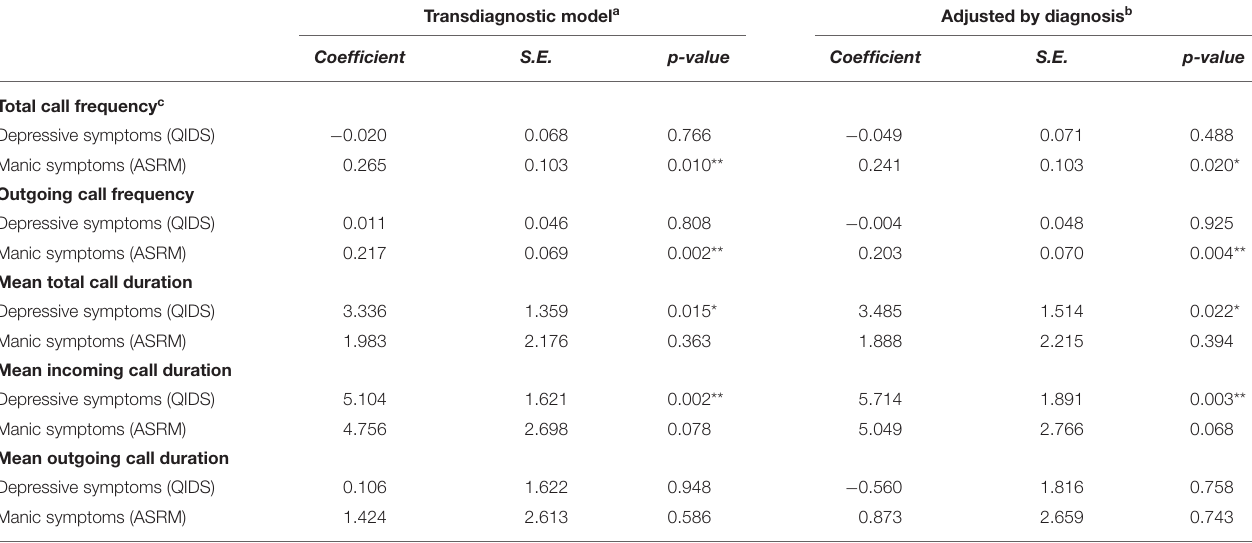
TABLE 2 | Phone call data by mood